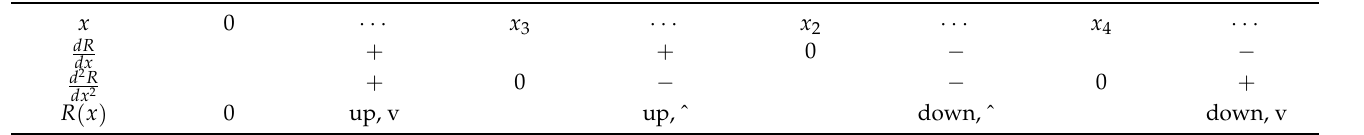
Note of Table 6: “v” means concave upward. “^” means concave downward.